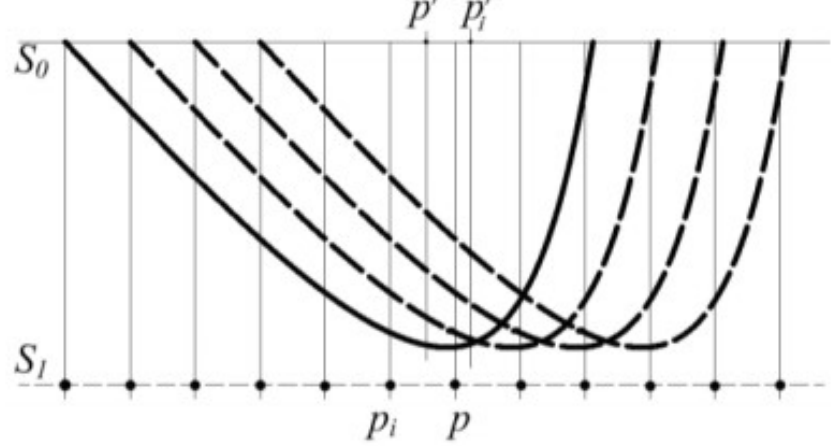
Figure 7. Schematic diagram of removal function convolution in the discontinuous direction.